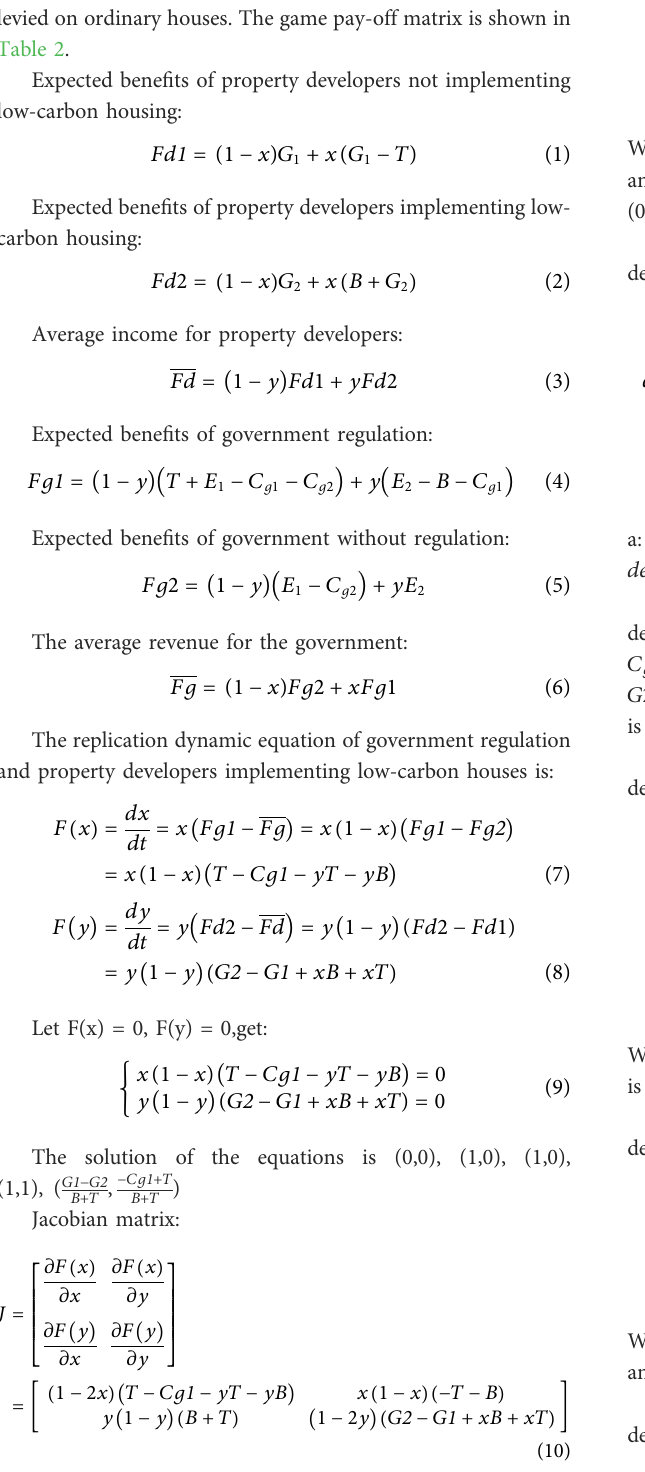
the equilibrium